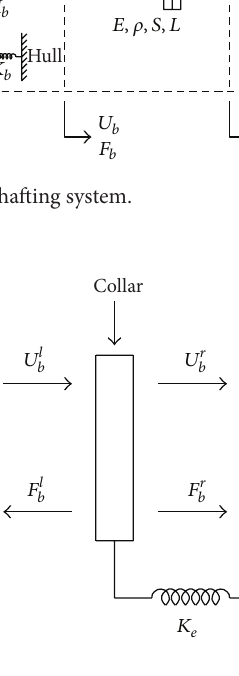
Figure 3: Equivalent mechanic model of thrust bearing and foun-